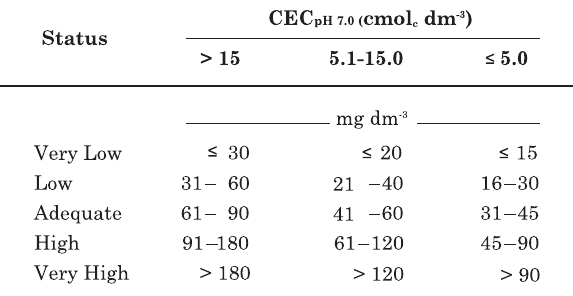
Table 4. Potassium status in soil from Southern Brazil 1 according to CEC pH